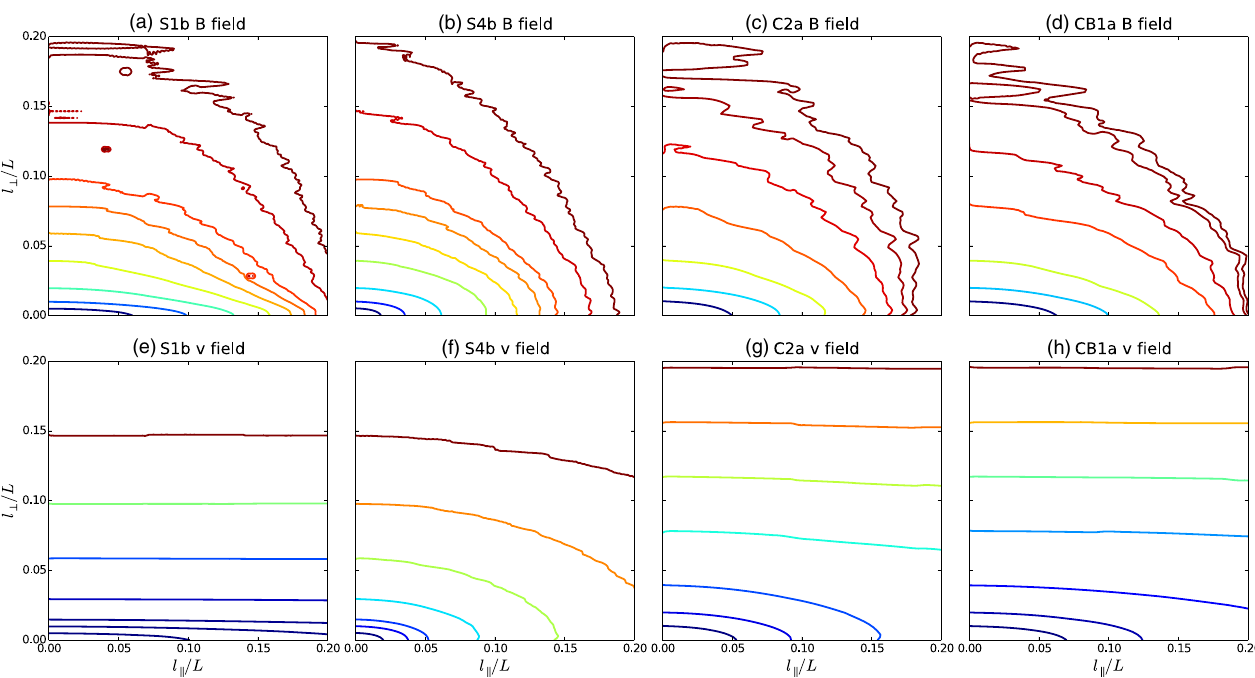
FIG. 7. Isocontours of the structure function for Alfv´en modes from their magnetic (top panels) and velocity fields (bottom panels) for the four simulations S1b, S4b, C2a, and CB1a. The units of l k and l ⊥ are in terms of the simulation box size. We see the scale-dependent anisotropy for the Alfv´en modes, which are longer in the parallel direction compared to the perpendicular direction.